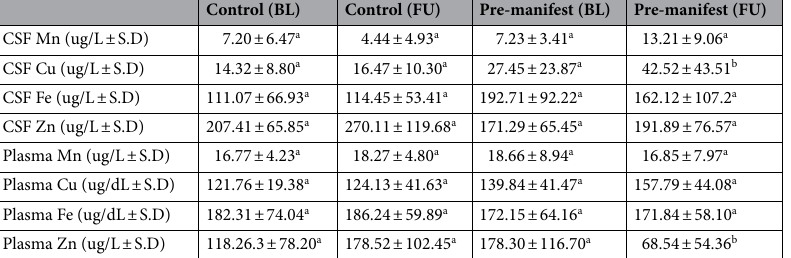
Table 2. Baseline and Follow-up Cerebrospinal Fluid and Plasma Metals in Control and Pre-manifest Participants. Differences between baseline and follow up cerebrospinal fluid and plasma metal levels in control and pre-manifest participants. Differences were examined using Mann–Whitney tests between visits and not explored across genotypes. Baseline (BL) and 4–8 week follow up (FU) cerebrospinal (CSF) and plasma manganese (Mn), Copper (Cu), Iron (Fe), Zinc (Zn) were measured using GF-AAS and shown here as mean ± S.D and values that do not significantly differ share a superscript.